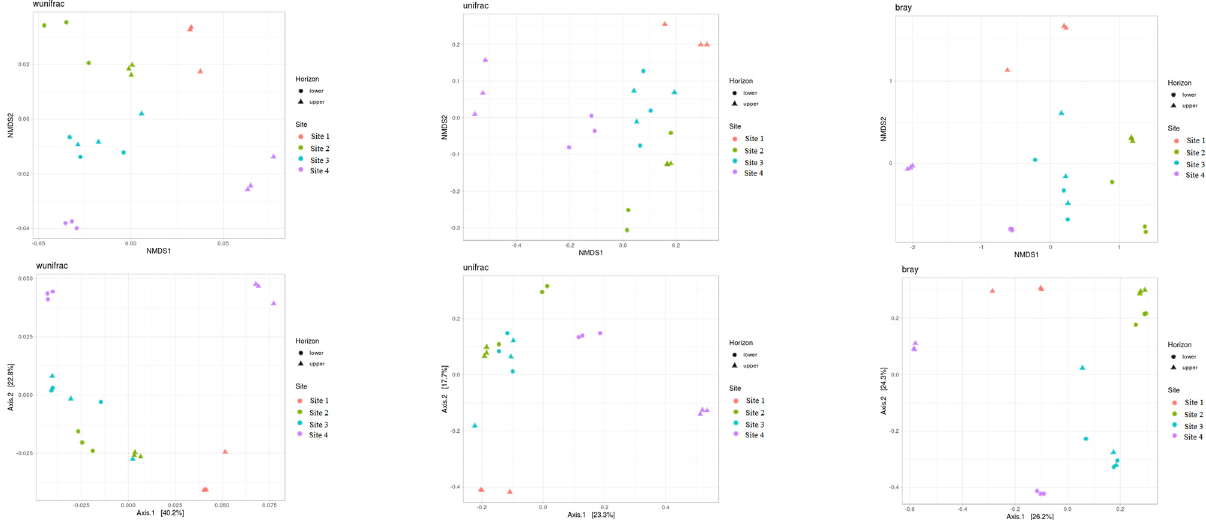
Figure 5: Beta biodiversity of soils